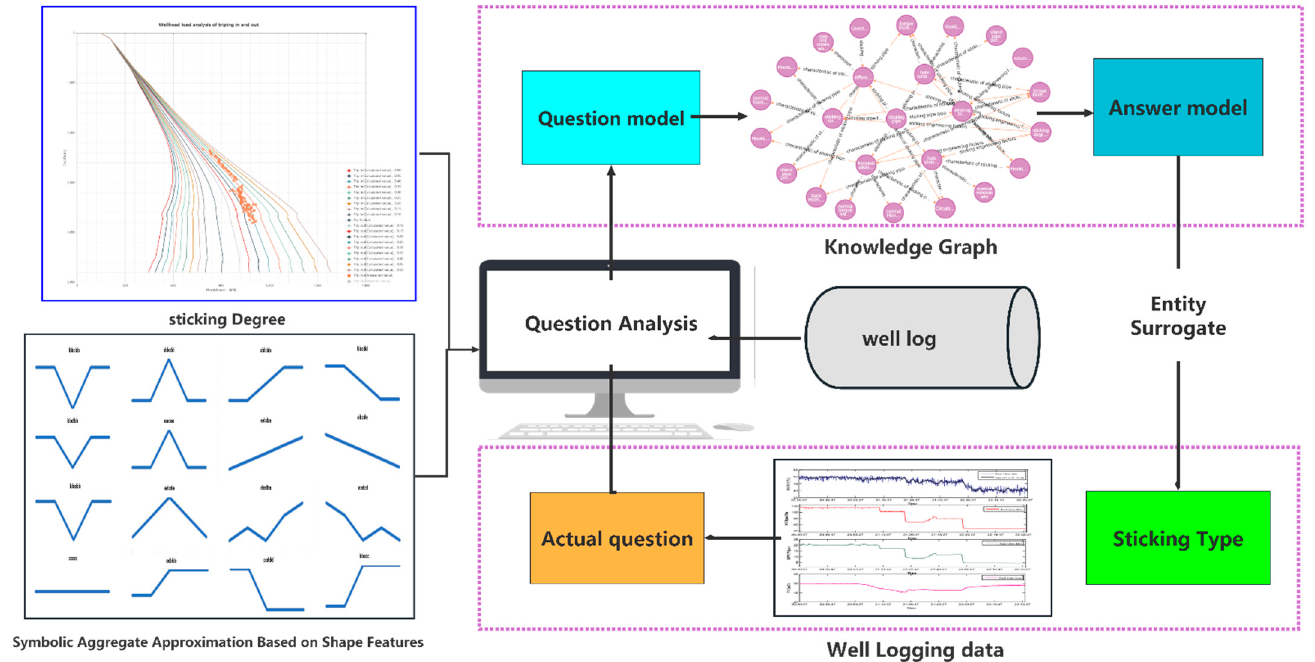
Figure 8. Recognition flow of stuck drill type using knowledge graph and digital twins.